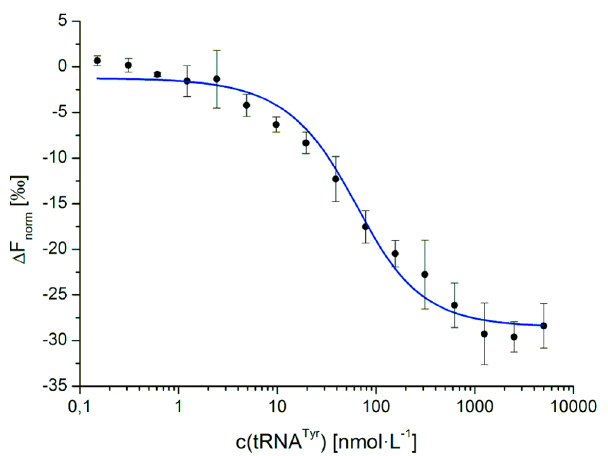
Figure 5. Binding of tRNA Tyr to Tgt measured by Microscale Thermophoresis. Alexa Fluor H 647 labelled Tgt at a concentration of 50 nmol ? L 2 1 was incubated with varying amounts of tRNA Tyr . The difference in normalised fluorescence as a measure of change in thermophoresis is plotted against the concentration of tRNA Tyr .